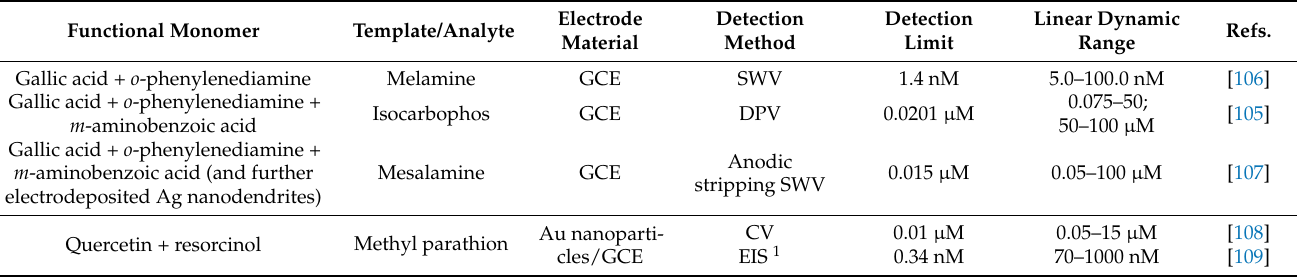
Table 5. Analytical characteristics of the imprinted electropolymerized natural phenolic antioxidant-based sensors for low-molecular organic compounds.